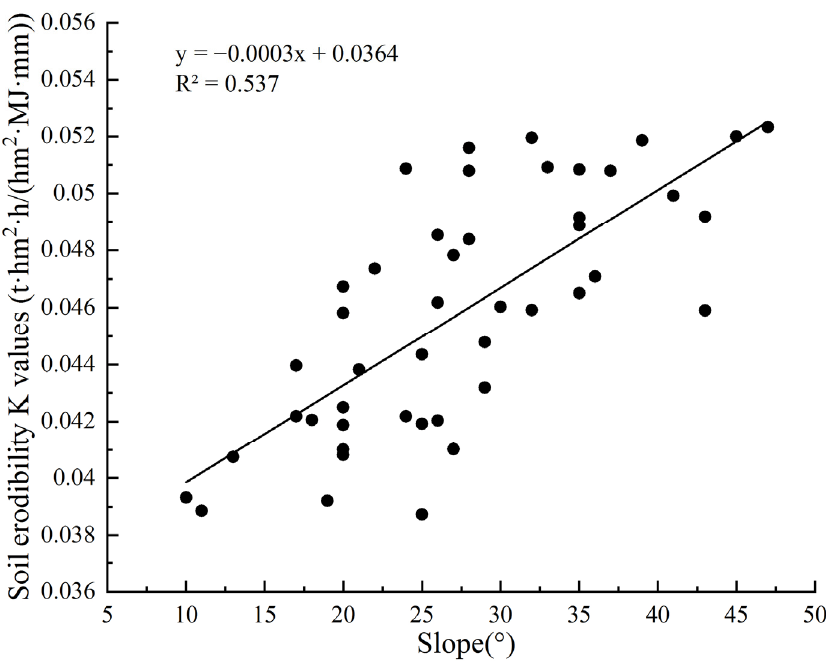
Figure 7. Correlation of soil erodibility K and slope.